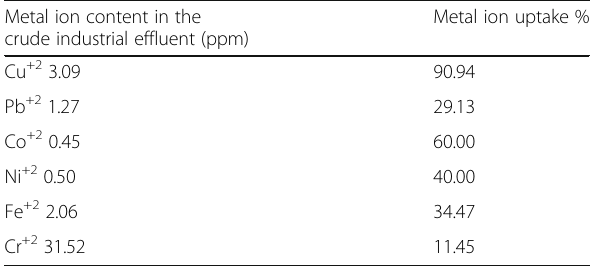
Table 4 Removal of heavy metal ions from an industrial effluent by alive Aspergillus tamarii NRC 3 biomass Metal ion content in the crude industrial effluent